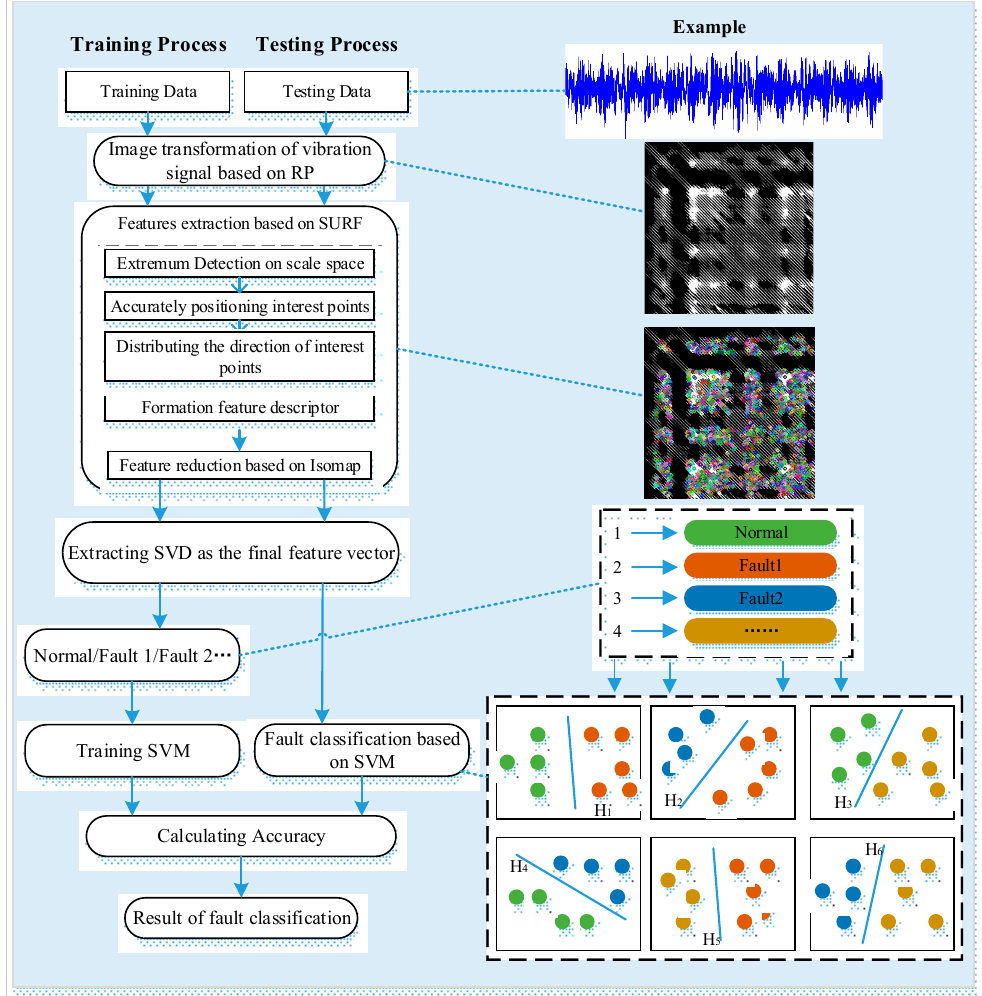
Figure 13. Flow diagram of the proposed method.